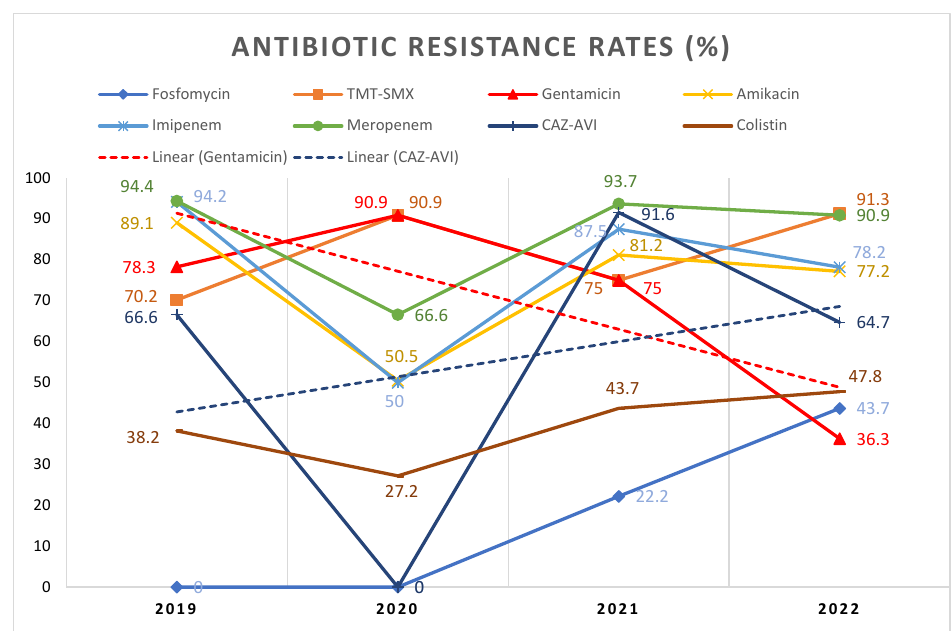
Figure 1. Antibiotic resistance rates during 2019–2022. The most significant changes (i.e., gentamicin and CAZ–AVI) are highlighted with supplementary linear trend lines. TMT-SMX—Trimethoprim-sulfamethoxazole; CAZ–AVI—Ceftazidime + avibactam.